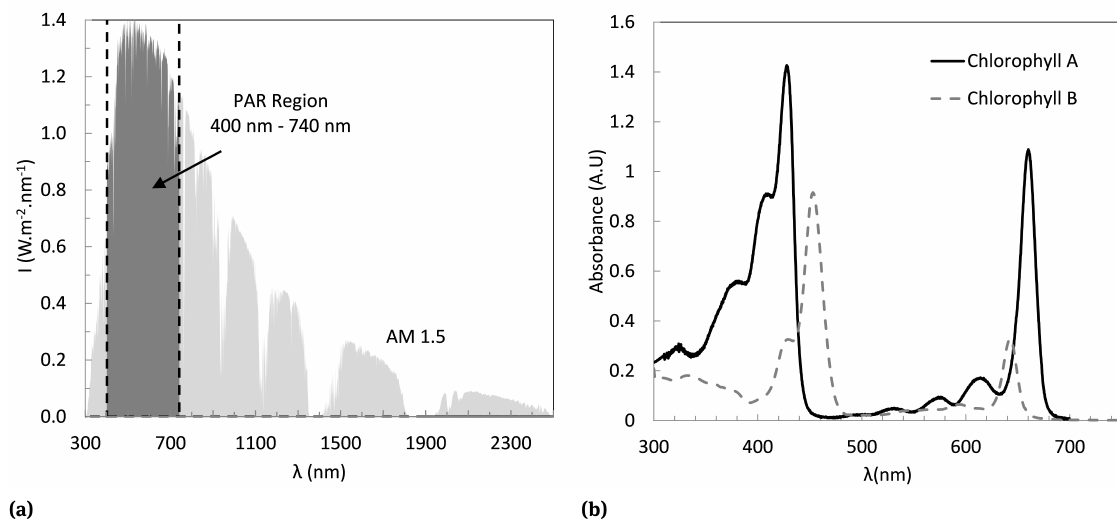
Figure 8: (a) Photosynthetically active radiation (PAR) utilized by plants for growth together with the terrestrial AM1.5 solar spectrum. (b) Absorption spectra of chlorophyll a and